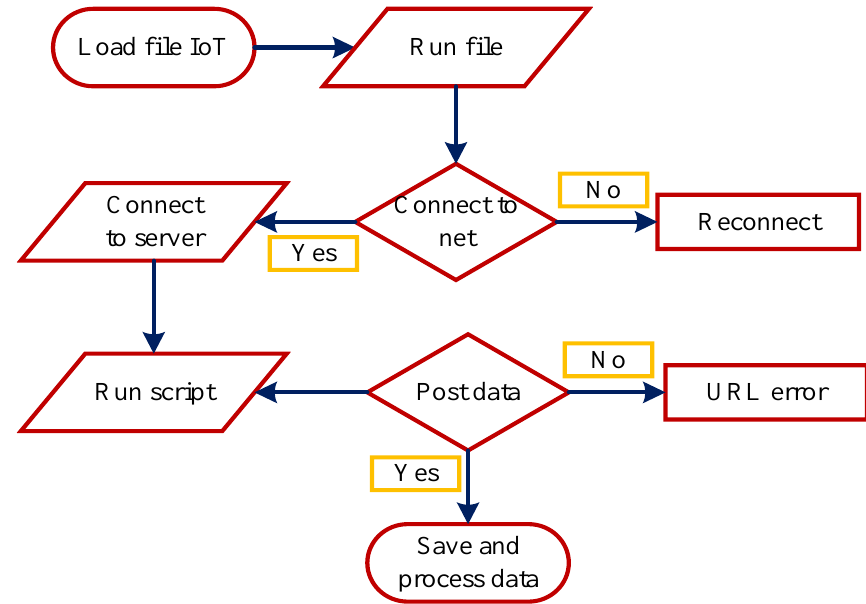
Figure 3. The flowchart of data transfer by the IoT platform.